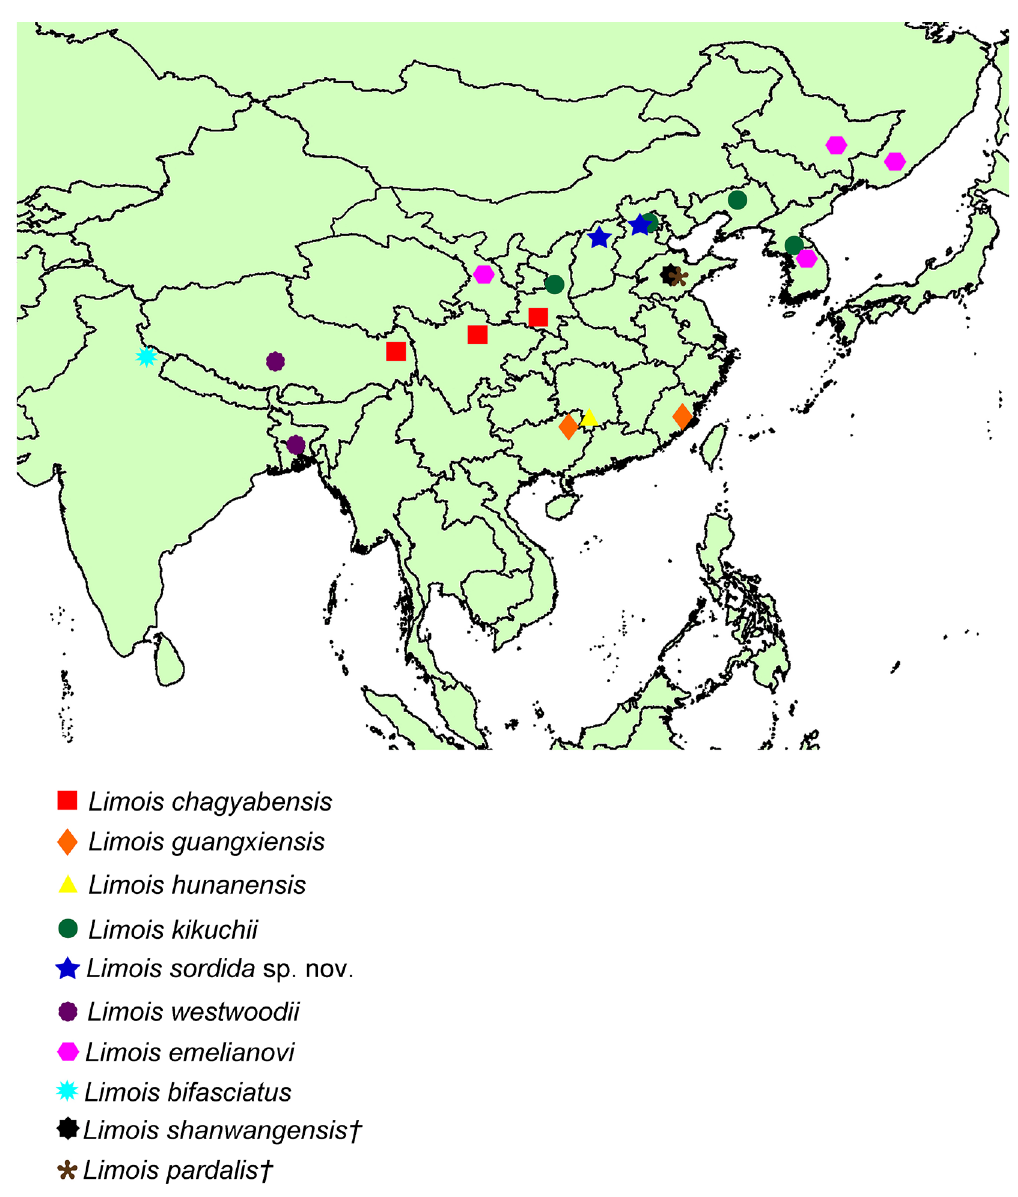
Fig. 16. Distribution map for species of Limois Stal,